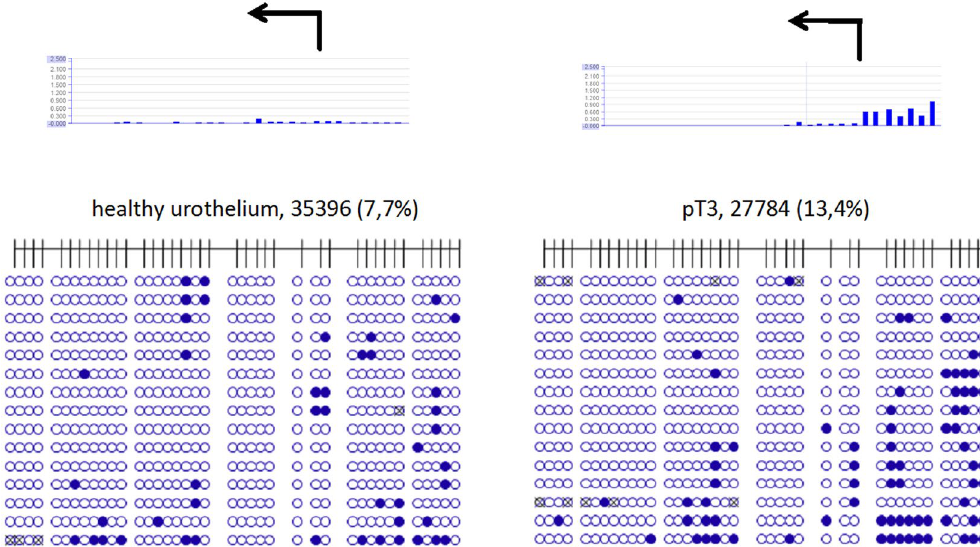
Figure 4. Detailed analysis by bisulfite sequencing of CpG island methylation patterns within 5 ′ - regulatory region of CBS gene in urothelium carcinoma. Stage and grade of UC tissue specimens with sample IDs (Table 1) are depicted above the panels. Above the first two panels, two corresponding array results are shown as bar plots. Each blue bar represents a 75 bp long CpG rich probe on the array. The height of a bar is proportional to the methylation degree. Underneath the corresponding detailed CpG methylation profiles of the CpG-rich 5 ′ regulatory region of CBS gene are documented as they were revealed by bisulfite sequencing from healthy urothelium and a pT3 UC tissue sample. Filled circles stand for methylated CpG dinucleotides. White circles stand for unmethylated CpG. Percentages in parentheses are indicating the respective methylated CpG portion. Circles which are crossed out stand for undefined CpG methylation status. Arrows indicate the transcription start site of CBS